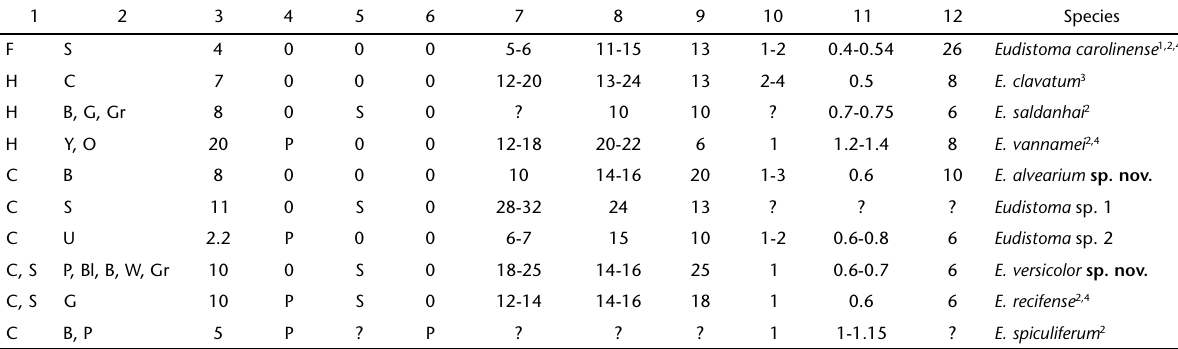
Table I. Key to the identification of Eudistoma in the Brazilian coast. (1) Colony shape: C – cushion, F – fingerlike projections, H – heads on cylindrical peduncles, S – spherical. (2) Colour of living colony: Bl = blue, B – brown, C – cream, G – grey, Gr – green, O – orange, P – purple, S – colour of the sand the covers the colony, U – uncolored, Y – yellow, W – white. (3) Zooid maximum reported size (mm). (4) Pigmentation of zooid: 0 – absent, P – present. (5) Organization of zooids in the colony: 0 – no systems, S – with systems. (6) Calcareous spicules in the tunic: 0 – absent, P – present. (7) Number of longitudinal muscle fibers in one side of the thorax. (8) Number of pharyngeal stigmata per row on each side. (9) Maximum number of testicular follicles reported. (10) Number of incubated embryos or larvae. (11) Size of larval trunk (mm). (12) Total number of ectodermal ampullae in